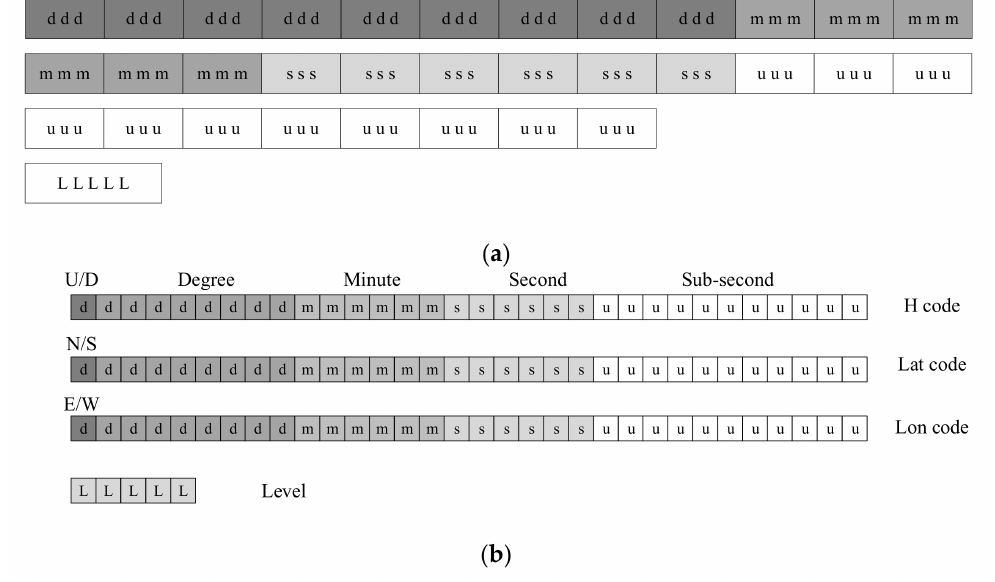
Figure 3. The composition of the binary code: ( a ) binary 1D code; ( b ) binary 3D